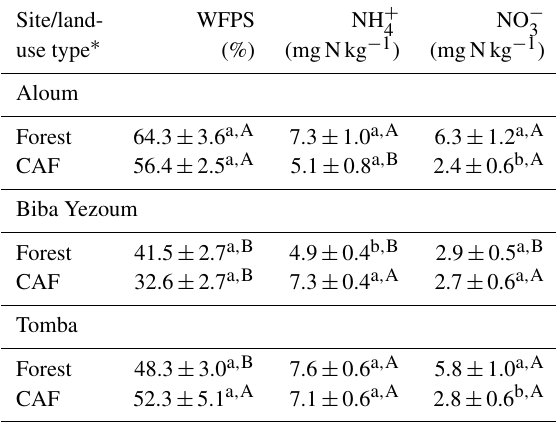
Table 4. Mean ( ± SE, n = 4) water-filled pore space (WFPS) and extractable mineral N in the top 5cm of soil in forest and cacao agroforestry (CAF) within each site in Congo Basin, Cameroon, measured monthly from May 2017 to April